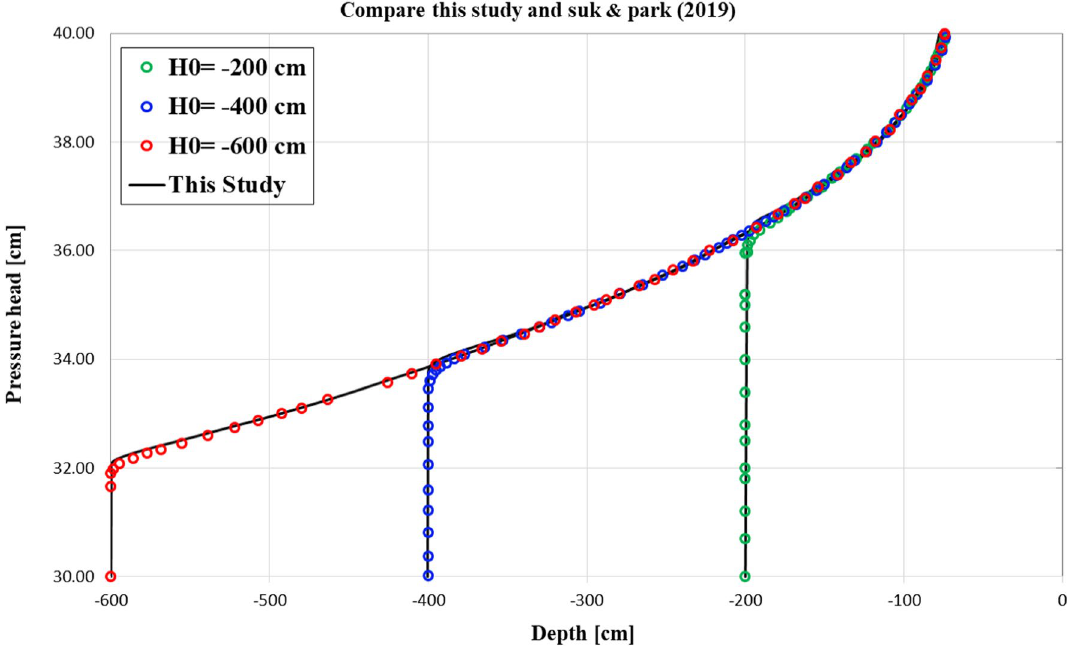
Fig. 5 Comparison of the suction profile modeled by meshless Petrov–Galerkin method and the numerical solution of the Richards equation (Suk and Park